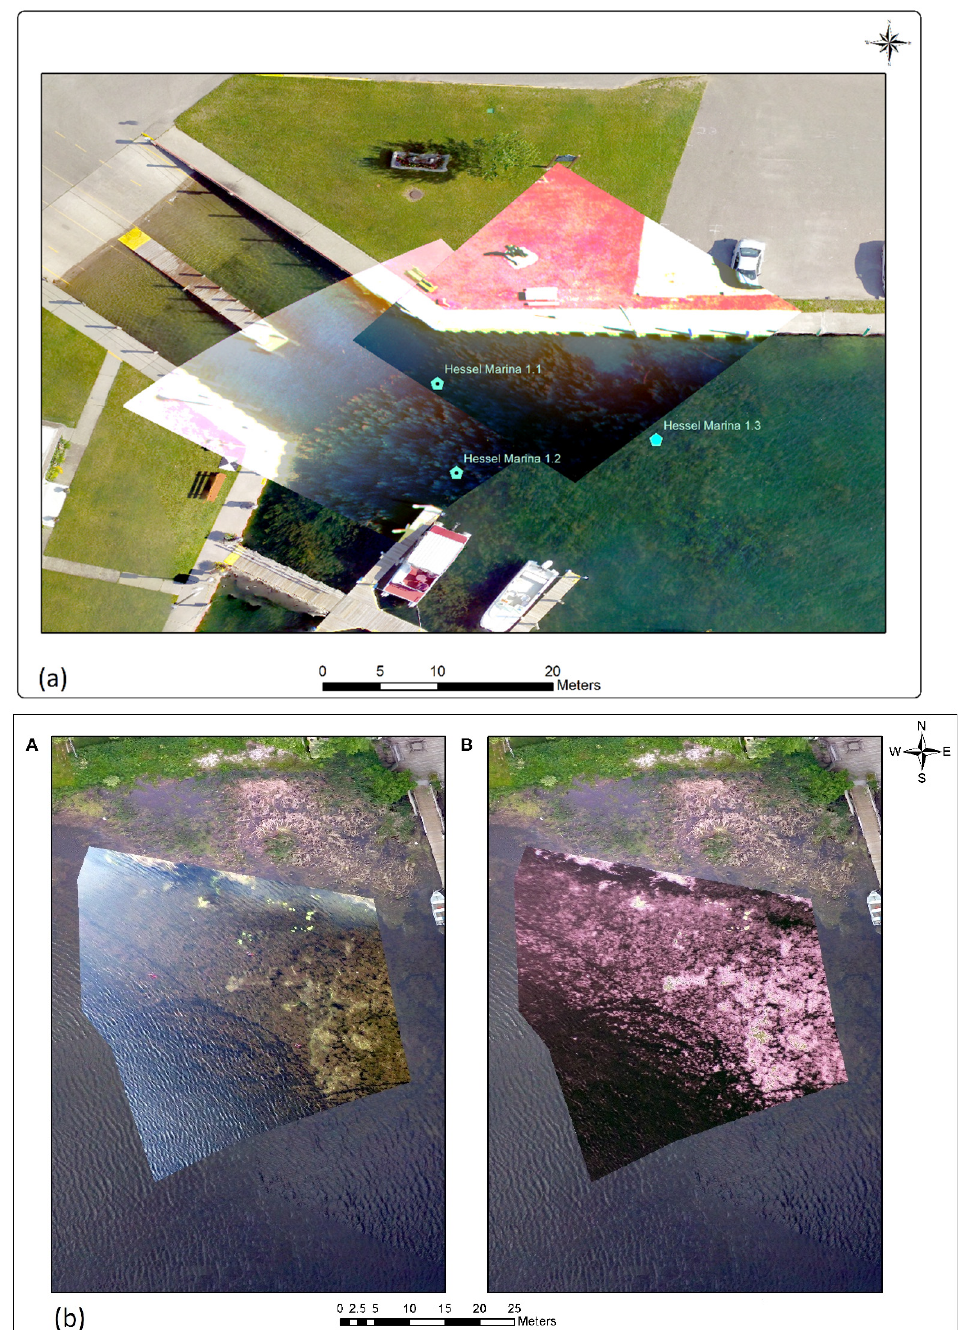
Figure 3. Two Tetracam images (top center ( a ), shown in color infrared) from July 2017, displayed over an RGB composite Phantom 3A image for the Hessel Marina site taken on the same day; green pentagons indicate field sampling sites. VISNIR imagery for the Court East site (bottom, ( b )) in June 2017, with RGB imagery shown at left ( A ) and near-infrared imagery shown at right ( B ).